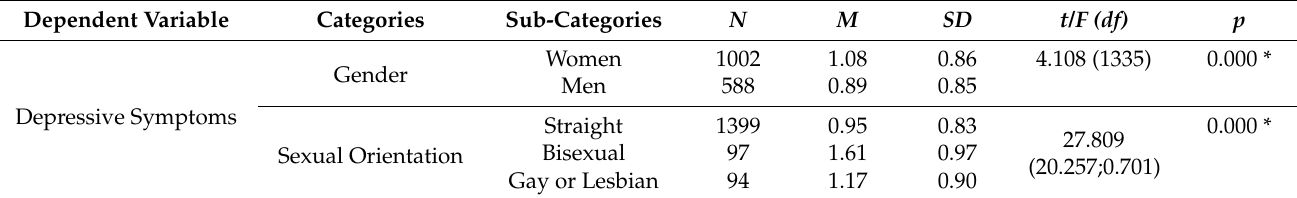
Table 2. Differences in Depressive Symptoms by Gender and Sexual Orientation.